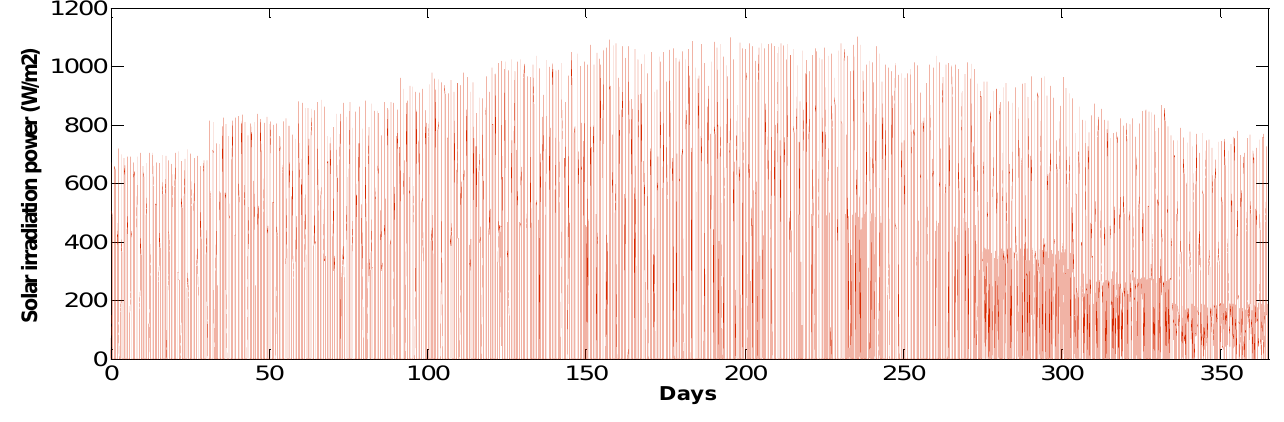
Figure 5. Solar irradiation during a year.